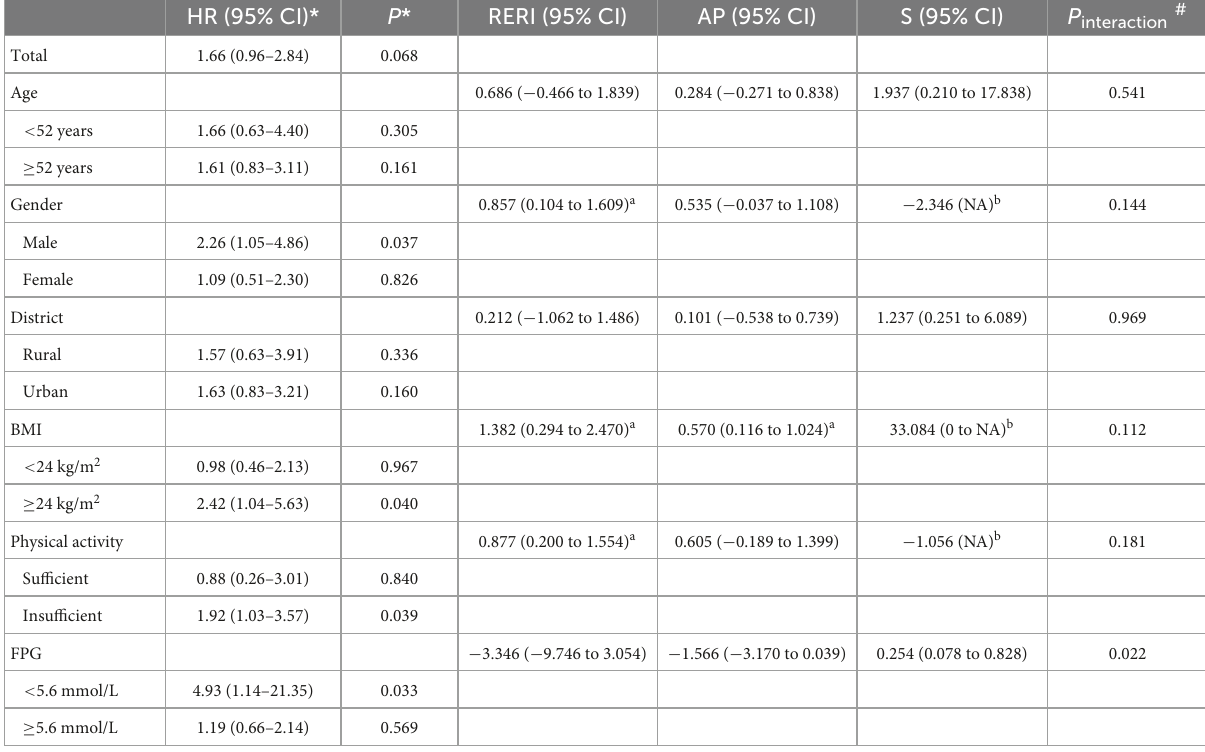
TABLE 5 Interactions between vitamin D deficiency/insufficiency and established risk factors on type 2 diabetes